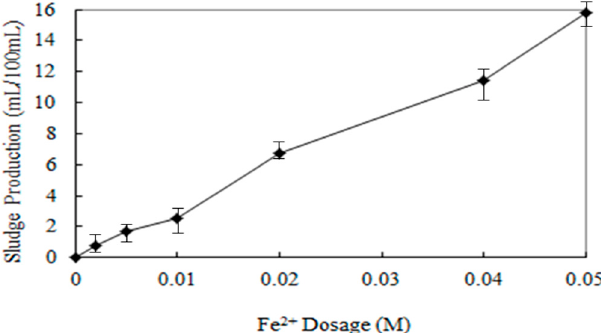
Figure 9. Production of sludge with Fe 2 + dosage (pH = 3.5, reaction time = 100 min, H 2 O 2 = 0.1 M, UV 254 intensity = 3.524 mW / cm 2 , settling time = 30 min).